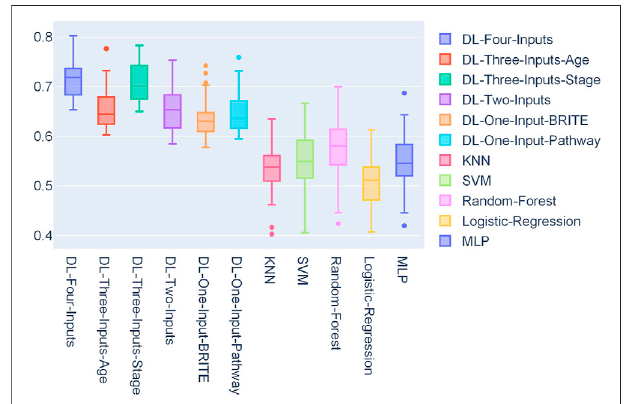
FIGURE4| Boxplotofthedistributionof50AUCsforeachmodelonthe TCGA lung cancer data set.